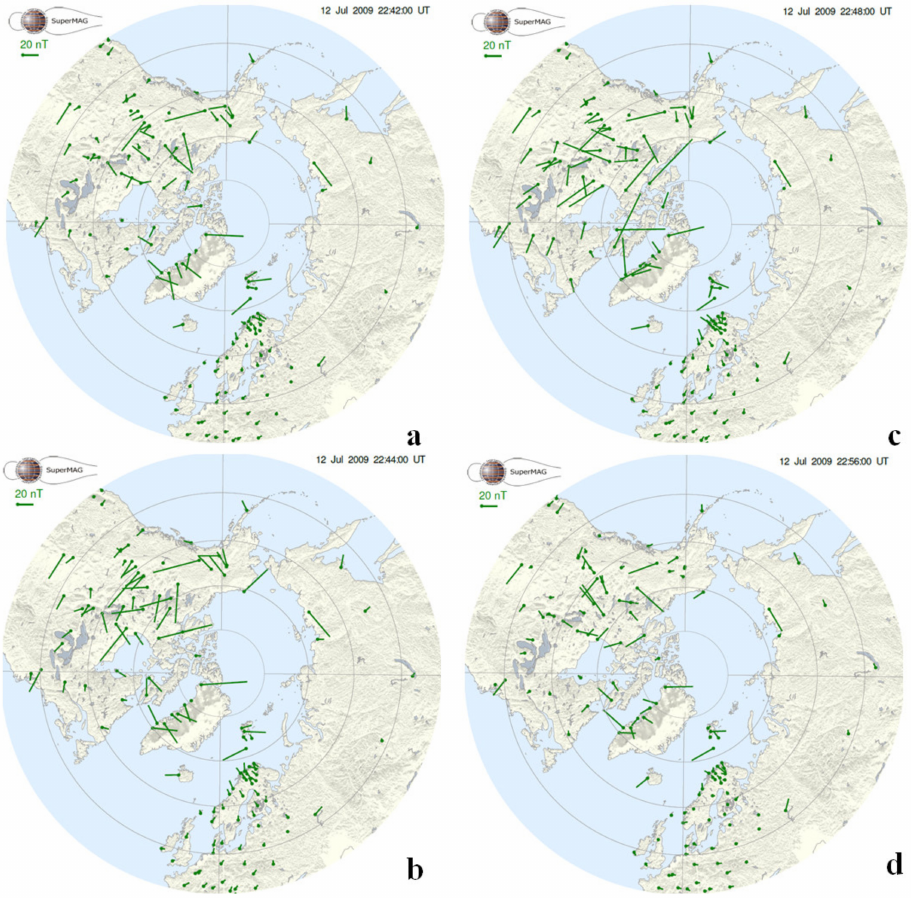
Figure 4. Polar maps of the equivalent ionospheric currents measured by the ground network of magnetometers SUPERMAG from 2242 to 2256 UT on 12 July 2009. The intensity of disturbances is indicated by green bars with a scale of 20 nT. The undisturbed map at 2242 UT is shown at panel ( a ). The variations were intensified at 2244 UT (panel ( b )) on the dayside (upper hemisphere), then they propagated through flank as shown at 2248 UT (panel ( c )) toward the nightside (lower hemisphere) and diminished at 2256 UT (panel ( d )). The amplitude of disturbances reached up to 100